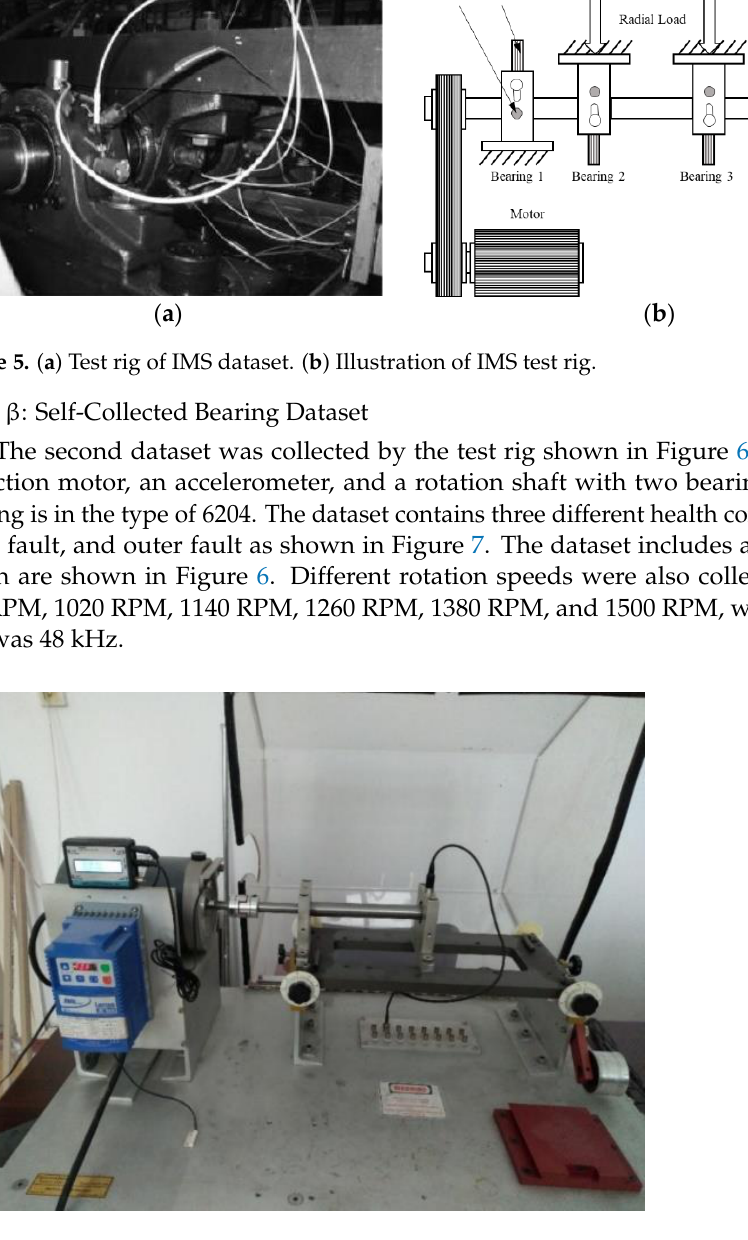
Figure 6. Test rig used to collect different speeds and different sample rate data.